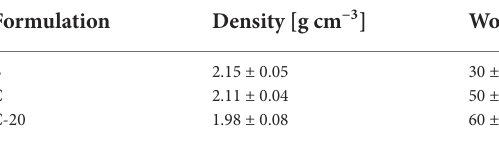
TABLE 3 Density,workabilityandsettingtimedata.